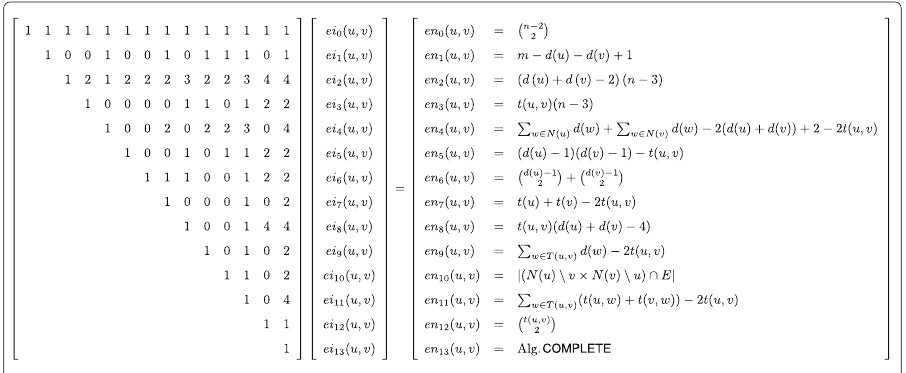
Fig. 3 System of equations for orbit-aware quad census on an edge level. ei refers to induced and en to non-induced counts